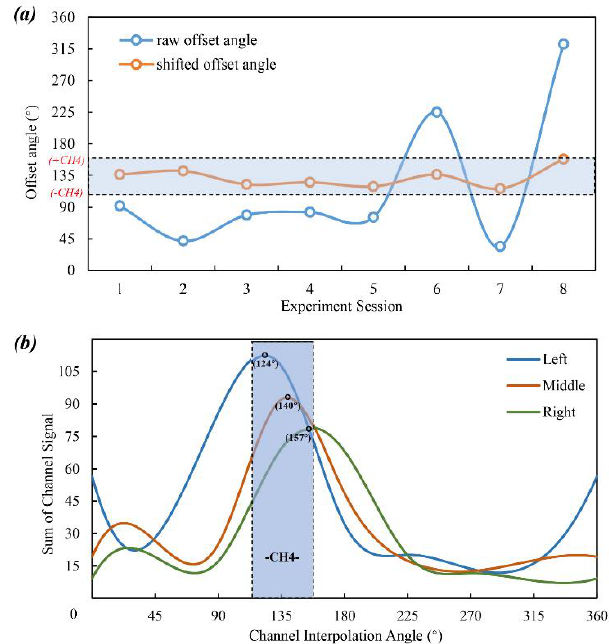
Figure 5. ( a ) Electrode shift on various experiments. ( b ) 3 representative wearing position for acquiring training